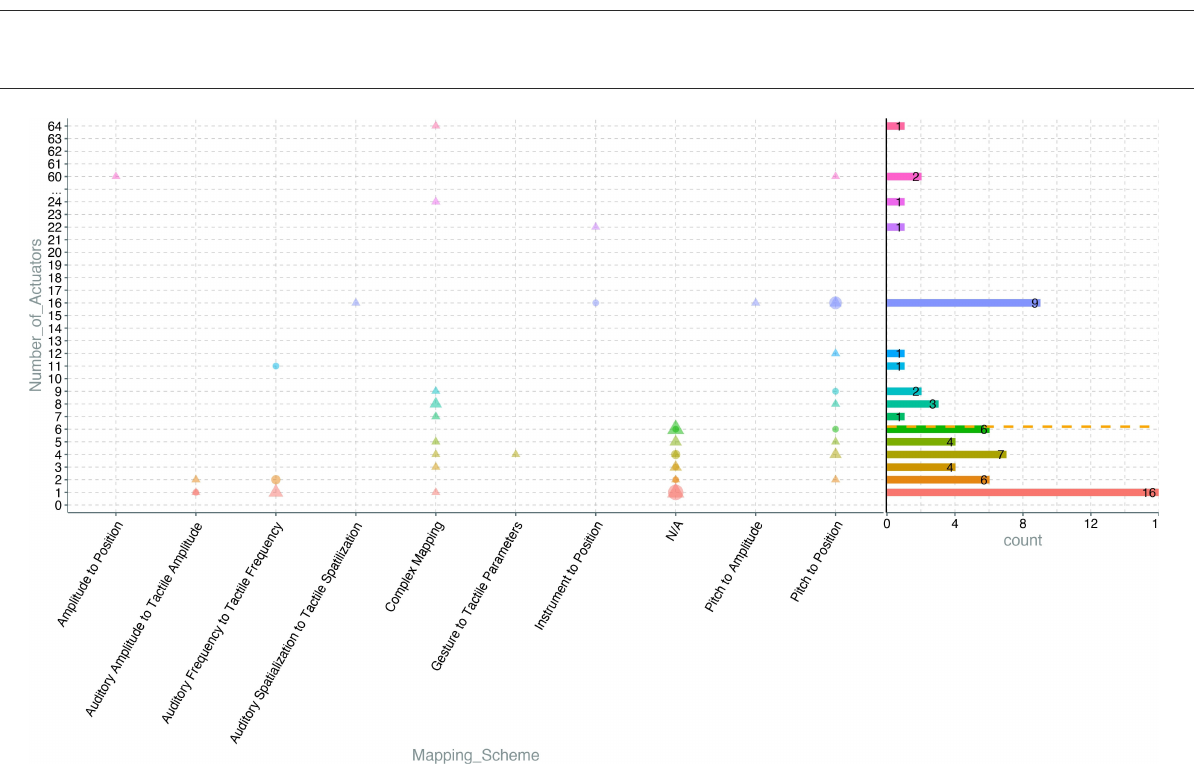
FIGURE6 Distribution of the number of actuators for each mapping scheme; a triangle indicates a wearable device, a circle indicates a fixed device and the size of the shape represents the amount of similar devices. The dashed orange line represents the